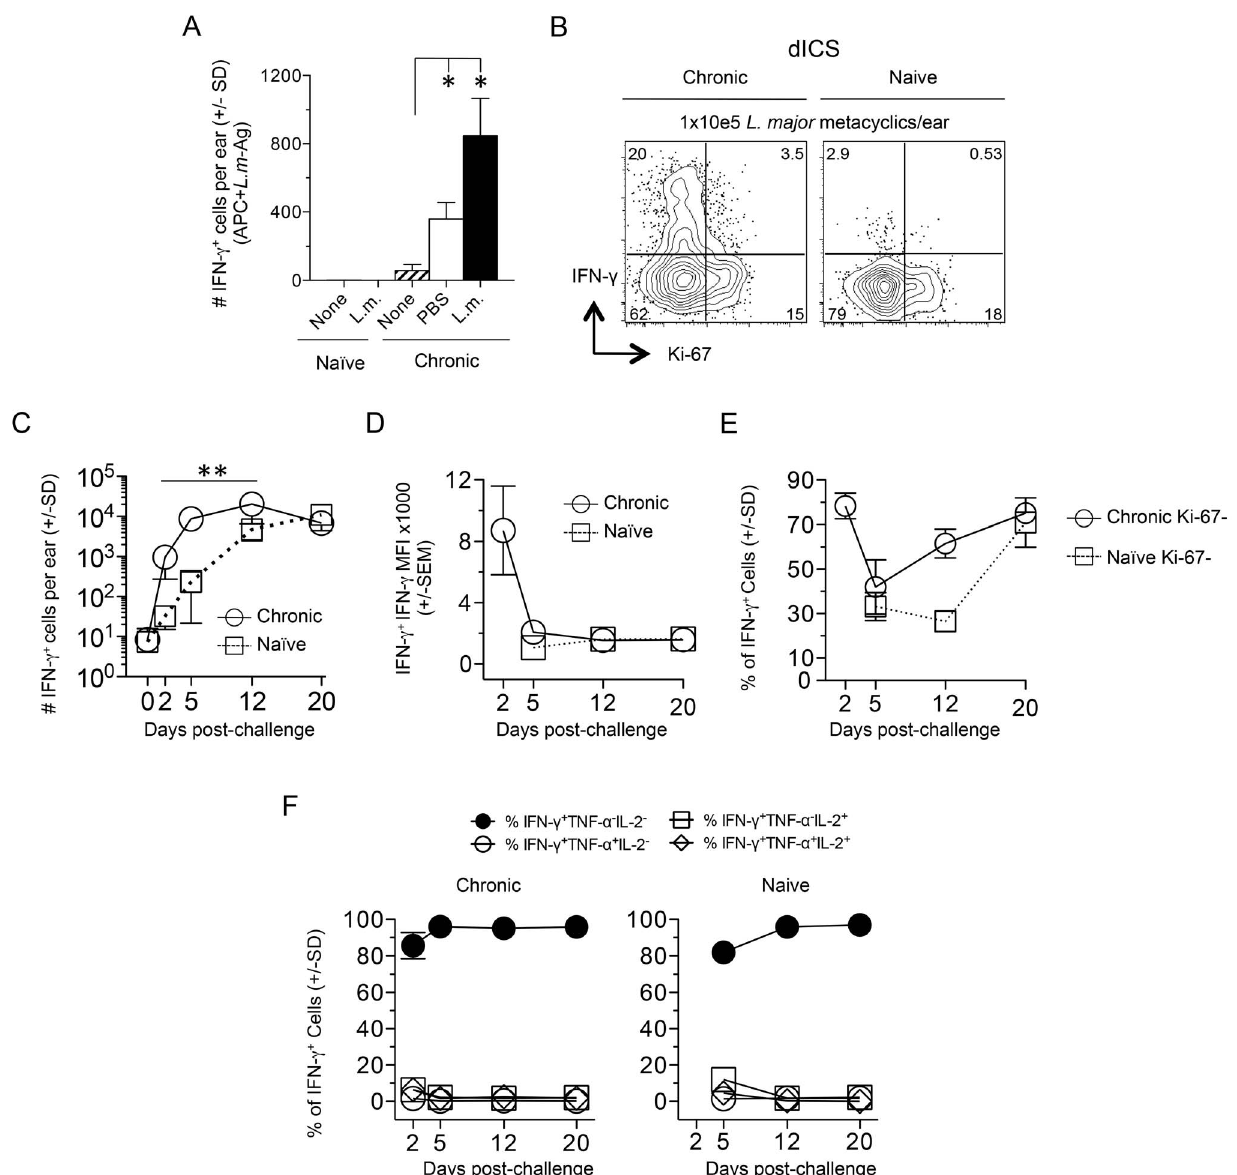
Figure 3. Kinetic analysis of CD4 + T cell cytokine production and proliferation history following needle challenge with L.major . Ears of naı¨ve or chronic mice were not challenged (None) or challenged by needle inoculation of PBS or 1–2 6 10 5 L.m. metacyclic promastigotes ( L.m. ). At the indicated time-points post-challenge CD3 + CD4 + T cells from the ear were analyzed by flow-cytometry. ( A ) 20 hours post-inoculation, ear-derived cells were analyzed for IFN- c -producing CD4 + T cells after over-night (14 hours) in-vitro APC + L.m. -Ag re-stimulation. (*) p , 0.05, n=3. ( B ) Representative dot-plot of IFN- c and Ki-67 expression following dICS on day 2 post-challenge. ( C ) The number of IFN- c + CD4 + T cells per ear following dICS as a function of time p.i. **, p # 0.002 on days 2, 5, and 12 comparing chronic versus naive. ( D ) Average IFN- c MFI of IFN- c + cells. ( E ) Percentage of IFN- c + cells that are Ki-67 2 . ( F ) Kinetic analysis of multi-cytokine producing cells as determined by dICS. Data in (C, E, and F) is pooled from two independent experiments; n=3 (day 0) or n=8 (days 2–20) for the Naı¨ve group and n=7 (day 0) or 6–8 (days 2–20) for the chronic group. Data in (A and B) are representative of two independent experiments.